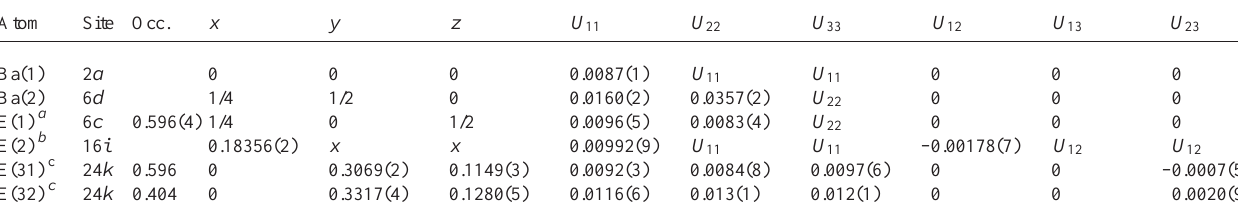
Table 2. Atomic coordinates and displacement parameters (in Å 2 ) .